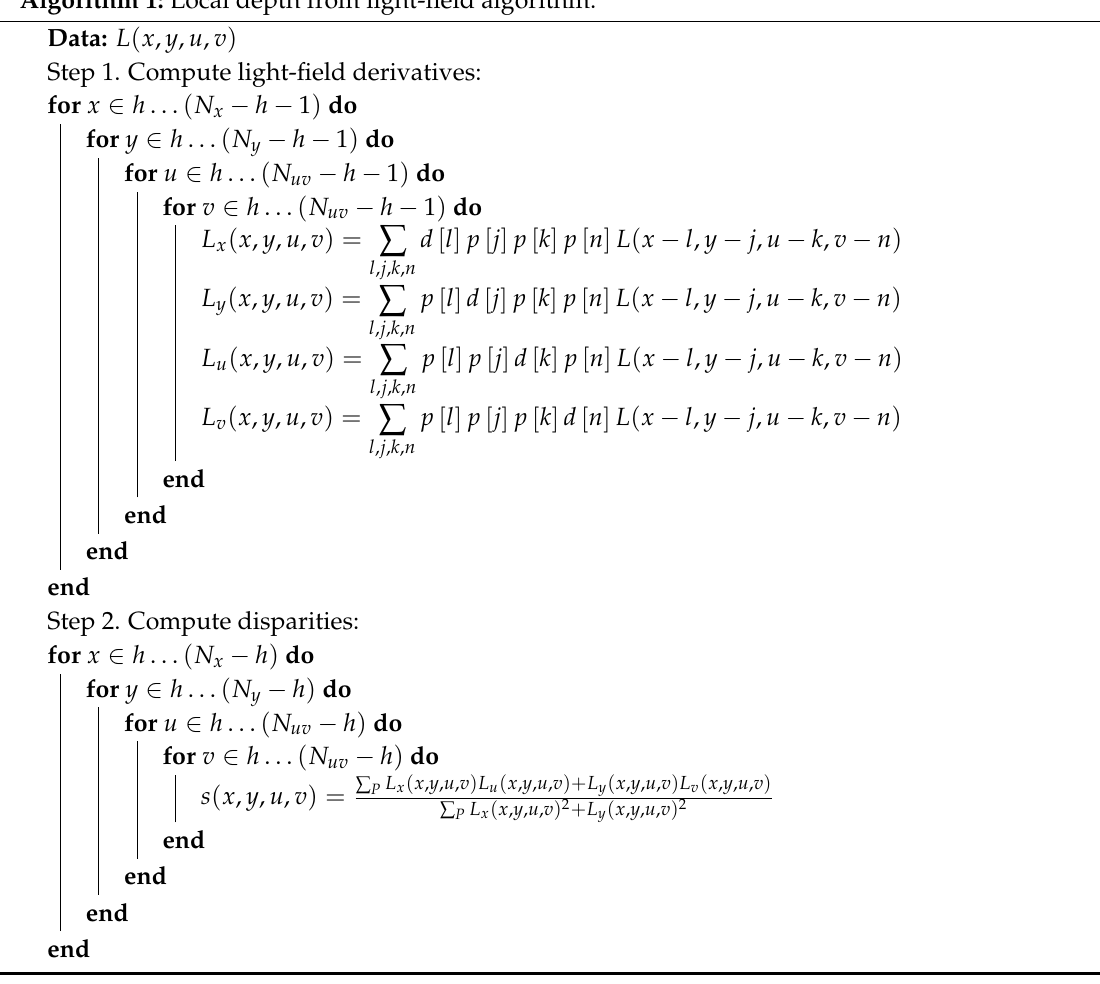
Algorithm 1: Local depth from light-field algorithm. Data: L ( x , y , u , v )